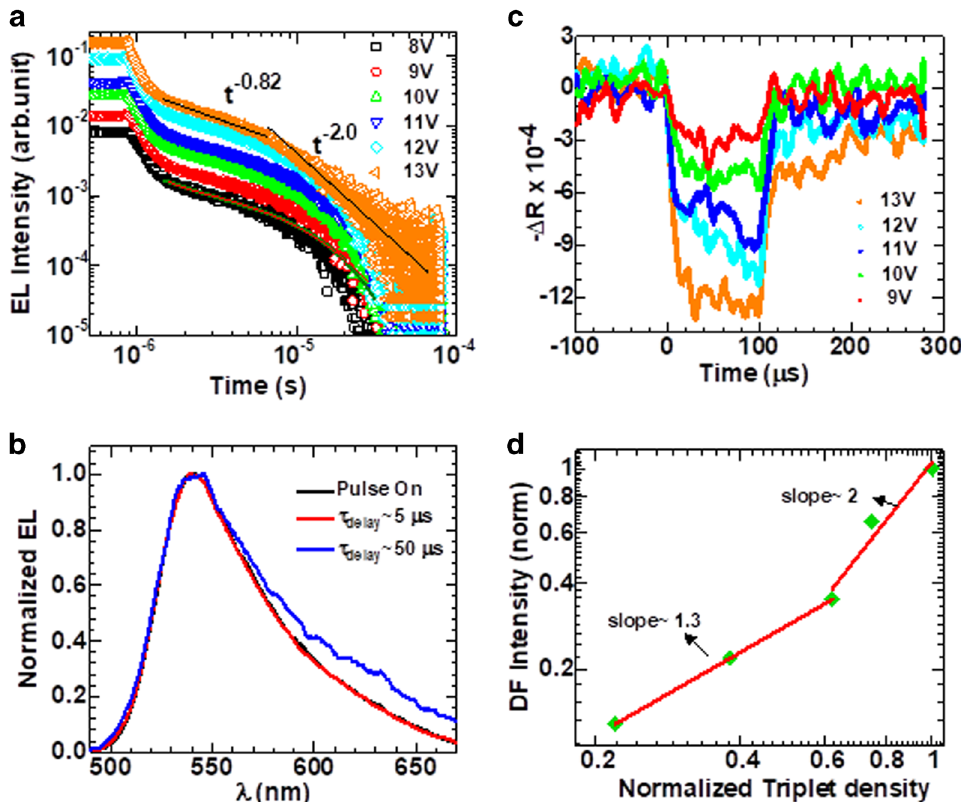
Fig. 2 Delayed Fluorescence under electrical excitation. a Electrically excited time-resolved emission kinetics from F8BT PLED at different bias pulse voltages. At lower voltages, the transient EL decay is exponential which changes to power-law decay at higher applied bias and can be fi tted with ~ t − 0.82 power law which changes to ~ t − 2.0 at longer times. b EL spectra during electrical pulse ON time and delayed emission with a time delay of 5 and 50 μ s in F8BT PLED. c Triplet absorption signal from F8BT PLEDs is captured by probing the device at λ = 780 nm (close